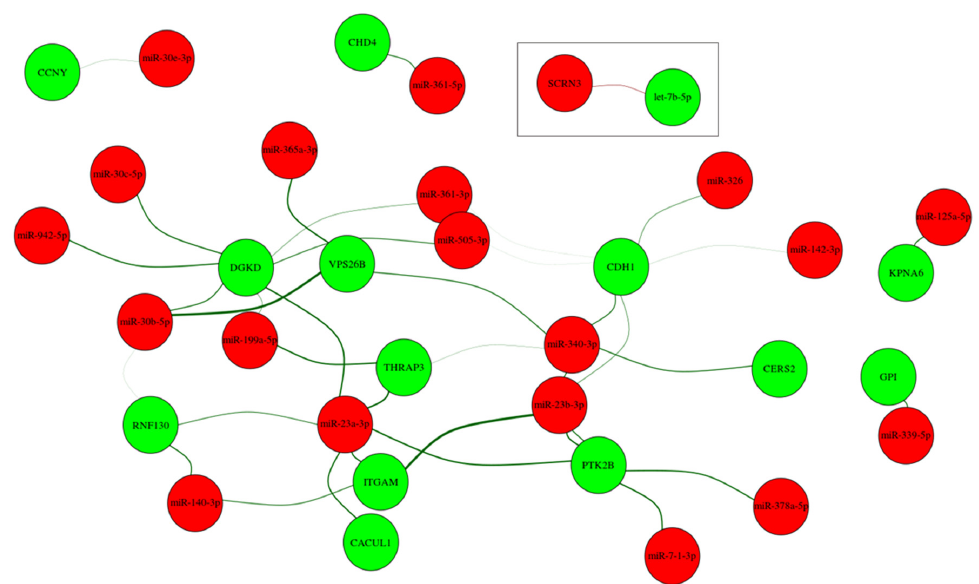
Figure 4. Network of the differentially expressed miRNA and their potential target mRNAs with inverse correlations and high differences in correlation between EA patients and healthy controls.